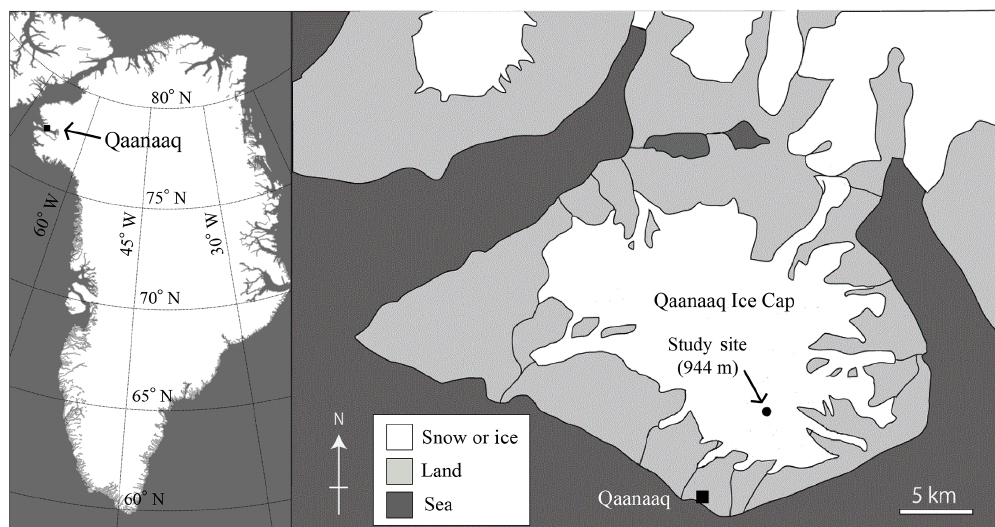
Figure 1. Map of Greenland (left) and Qaanaaq Ice Cap in northwest Greenland (right). The figure to the right shows the sampling site on the